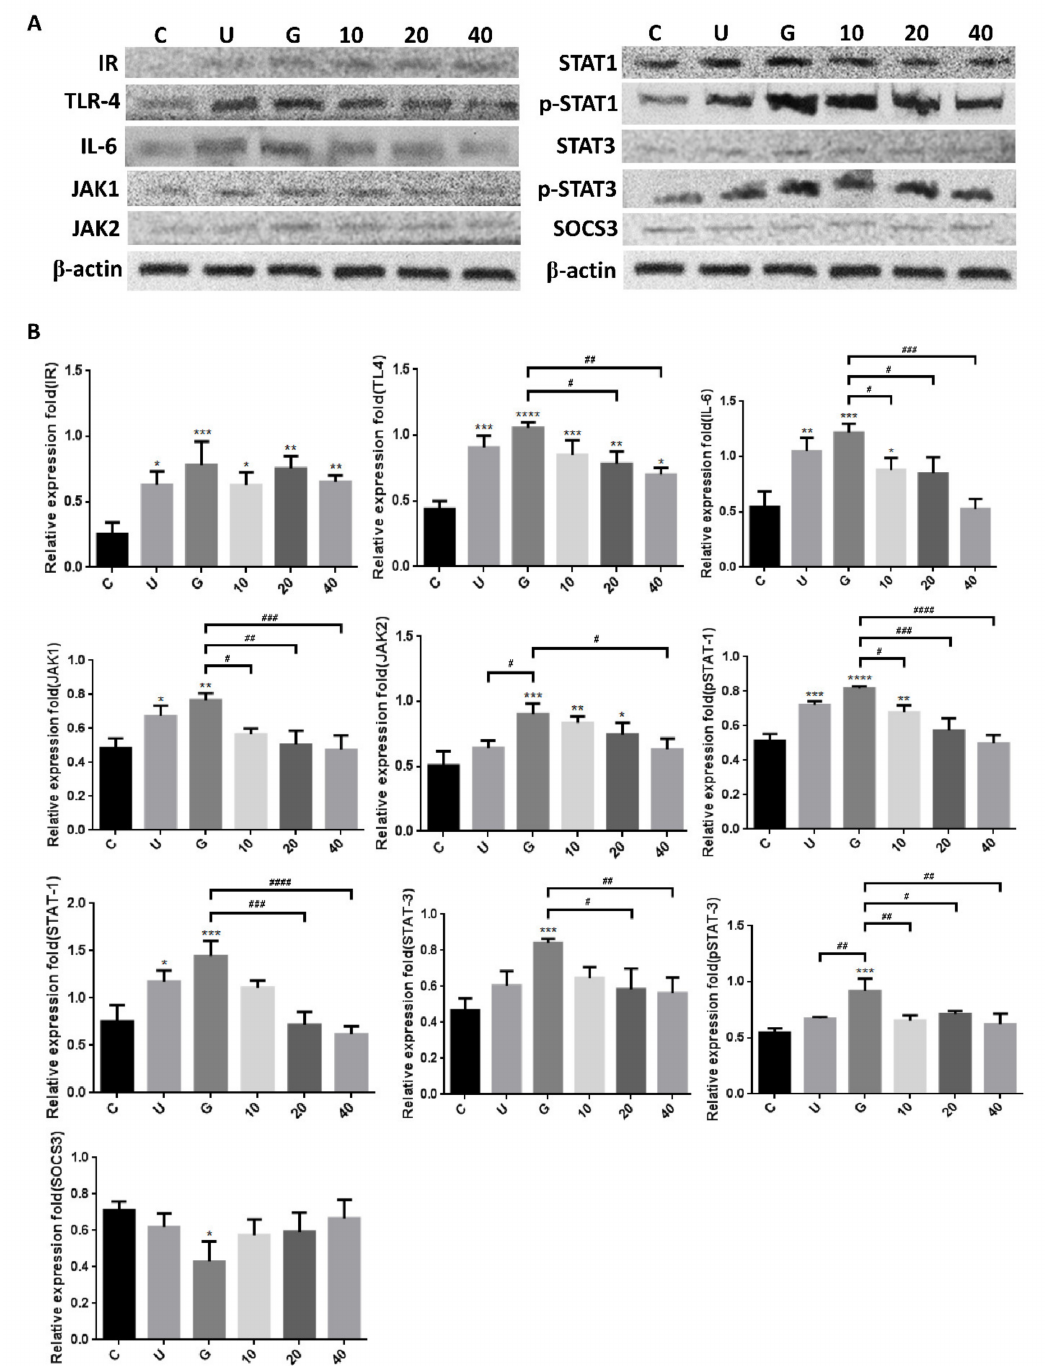
Figure 7. Insulin downregulated the expression of proteins associated with the JAK/STAT1 signaling pathway and inflammation in UPEC-infected bladder cells in high-glucose environment. SV-HUC-1 cells were pretreated with 10, 20, and 40 µ g/mL insulin and 15 mM glucose for 24 h, and then infected with UPEC. Total protein from all the cell groups was collected for detection. ( A ) Total protein expression of JAK1, JAK2, STAT1, STAT3, phosphorylated-STAT1/STAT3 and the inhibitor, SOCS3, TLR-4, IL-6, and insulin receptor (IR) were analyzed by western blotting. ( B ) All data were normalized to the internal reference β -actin. Results were assessed using a densitometer and quantified using ImageJ software (NIH). The definitions of each letter/number represented by the X axis are: C: control; U: UPEC infection alone; G: with 15 mM glucose pretreatment; 10, 20 and 40: pretreated with 10, 20 and 40 µ g/mL insulin, respectively + 15 mM glucose. The results are presented as the mean ± SD of three independent experiments. * p < 0.05; ** p < 0.01; *** p < 0.001, **** p < 0.0001, compared to positive control groups. # p < 0.05, ## p < 0.01, ### p < 0.001, #### p < 0.0001, compared between the two